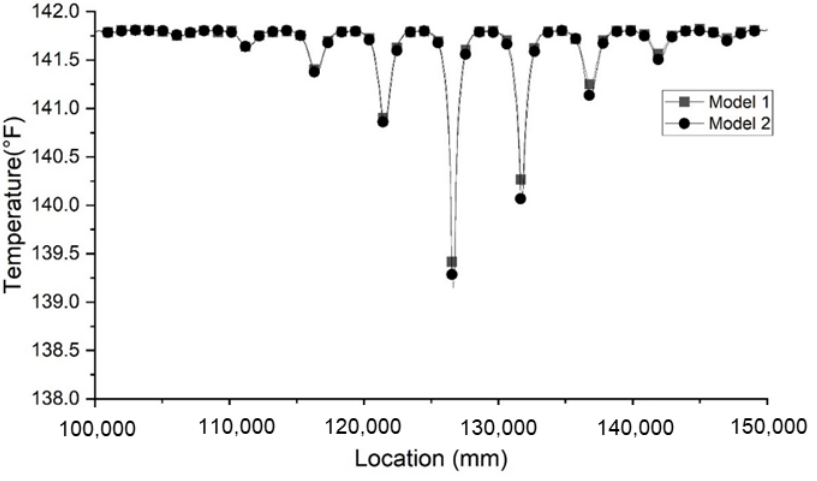
Figure 12. Comparison of two models with different dimensions of defects but the same